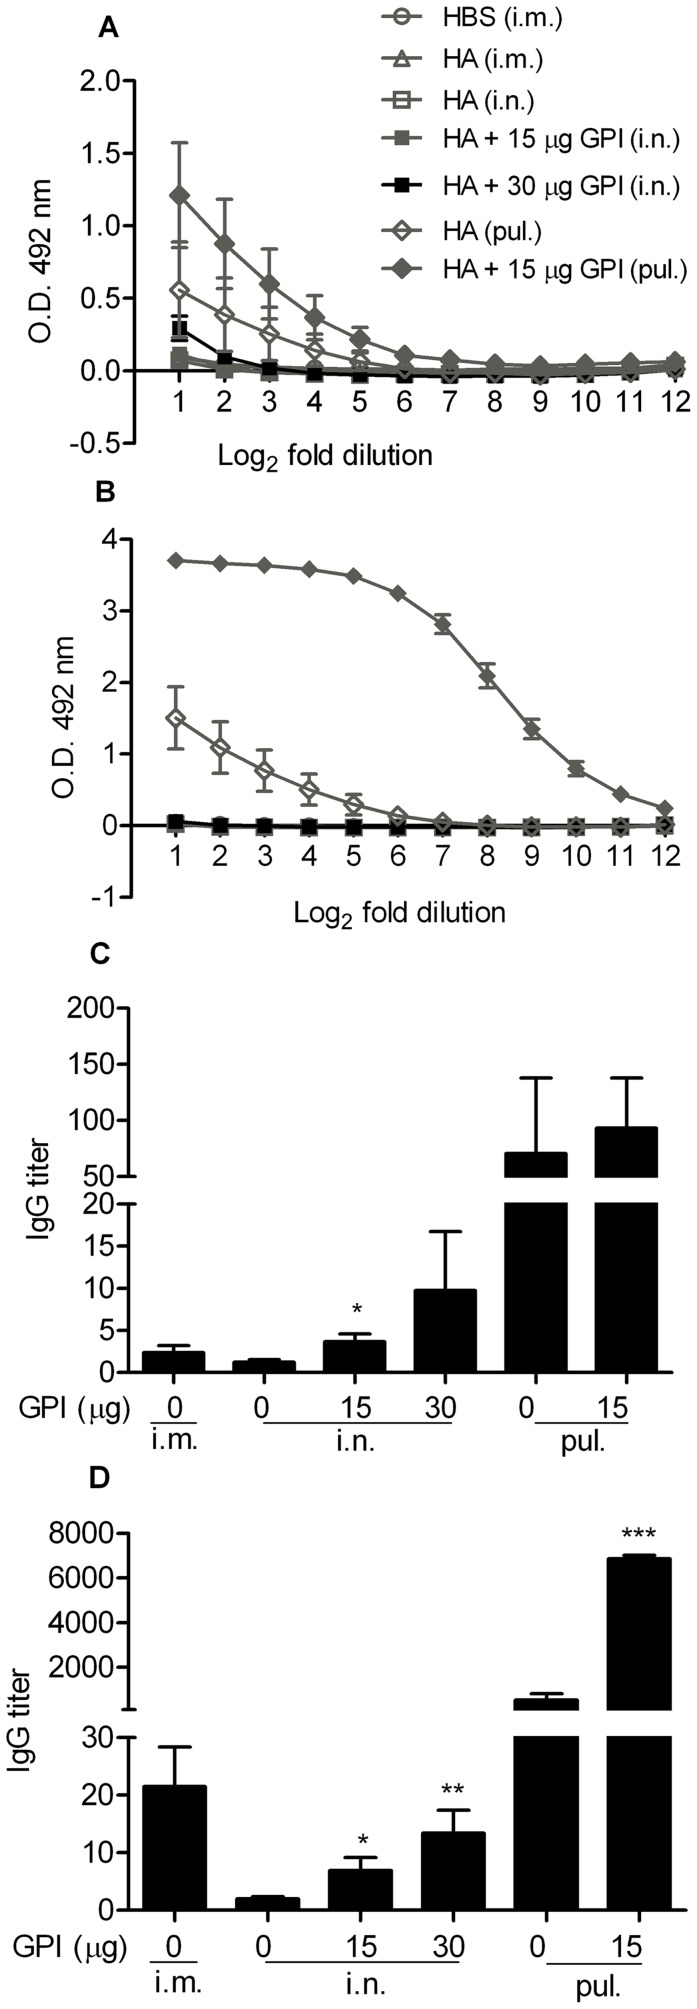
Influenza-specific mucosal IgA and IgG responses elicited by unadjuvanted and GPI-0100-adjuvanted mucosal influenza vaccine.Nose and lung wash samples from the mice described in the legend to Fig. 4 were collected on day 27 upon termination. (A) Nasal IgA responses after two immunizations. Average OD492 at each dilution ± S.E.M., n  = 6 mice per group. The starting and ending dilution is 2 and 4096 respectively. (B) Lung IgA responses after two immunizations. (C) Nasal IgG responses after two immunizations. Average IgG titers ± S.E.M. Due to technical reasons only 5 samples from mice receiving unadjuvanted intrapulmonary immunization were available. (D) Lung IgG responses after two immunizations. Due to technical reasons only 5 samples from mice receiving HBS and intrapulmonary immunization were available.